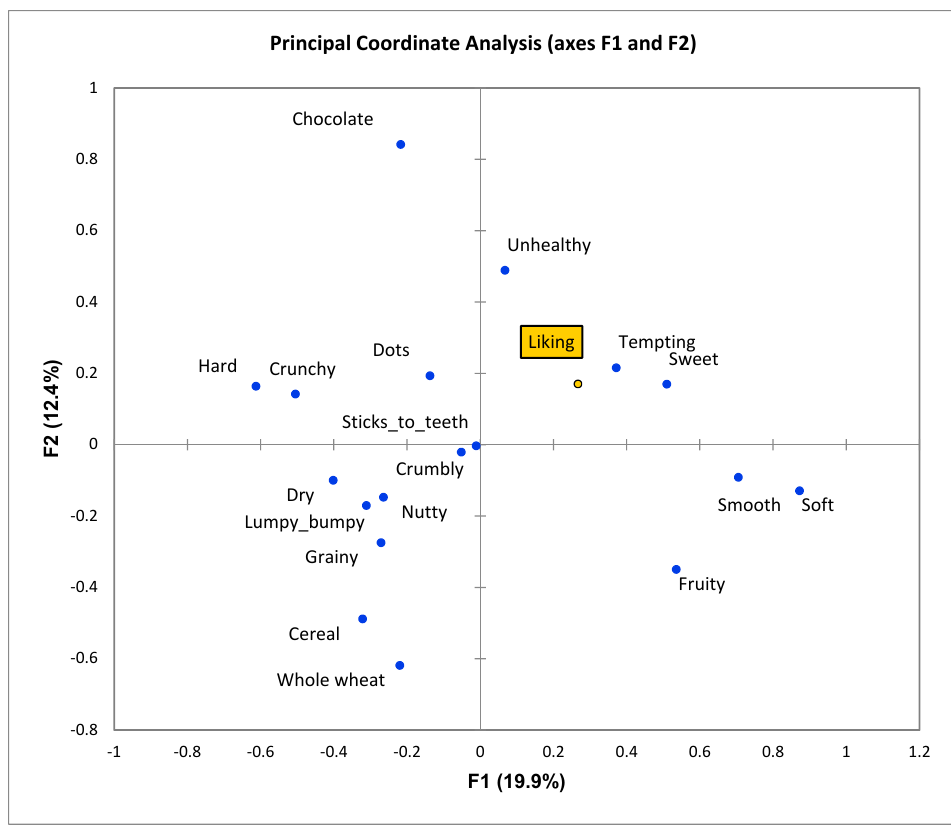
Figure 1. Principal coordinate plot based on CATA descriptions and liking of eight biscuits for the whole sample of children ( n = 509).